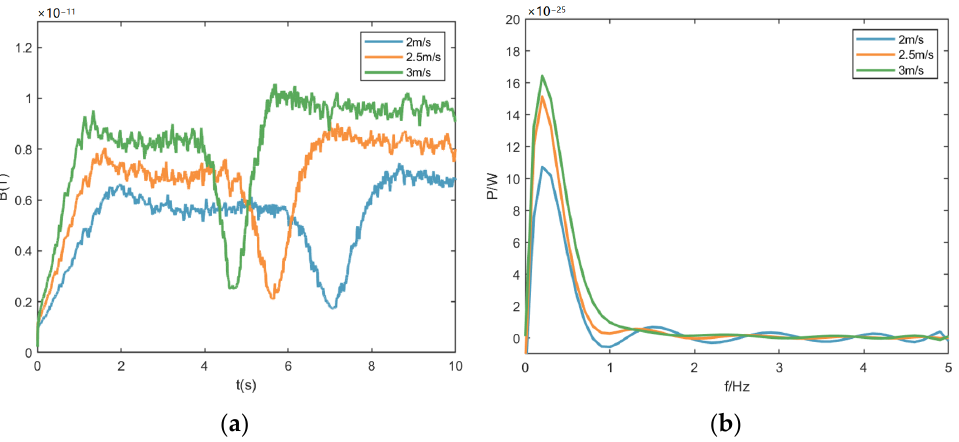
Figure 12. Magnetic field time domain and power spectrum of the submarine passing through monitoring point C at different speeds. ( a ) Time domain and ( b ) power spectrum.